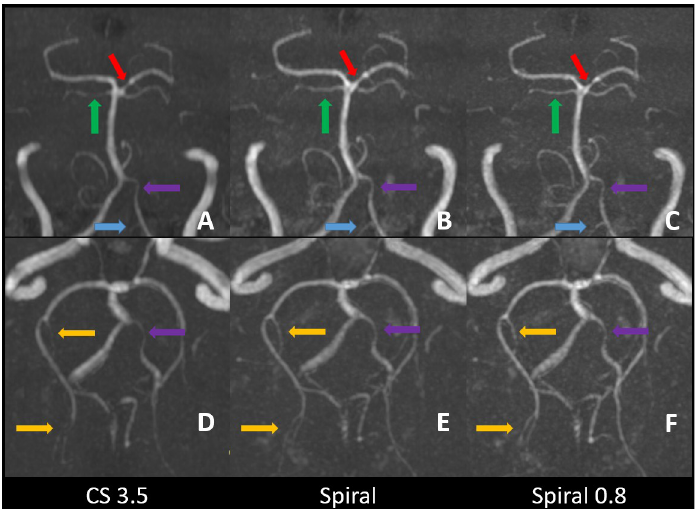
Fig 4. Zoomed coronal and transverse MIP images of CS 3.5 (A,D), Spiral (B,E) and Spiral 0.8 (C,F). A moderate stenosis in the P1 segment of the left posterior cerebral artery (red arrows) is well depicted in all three sequences. Small arterial branches as the right superior cerebellar artery (green arrows), the left posterior inferior cerebellar artery (blue arrows) and arterial branches of the right posterior cerebral artery arising from the P2 to P4 segments (yellow arrows) are more consistently shown on Spiral-TOFs than on CS 3.5 TOF. Hypoplastic arterial segments as the distal V4 segment of the vertebral artery on the left side are visible on all three sequences (purple arrows).